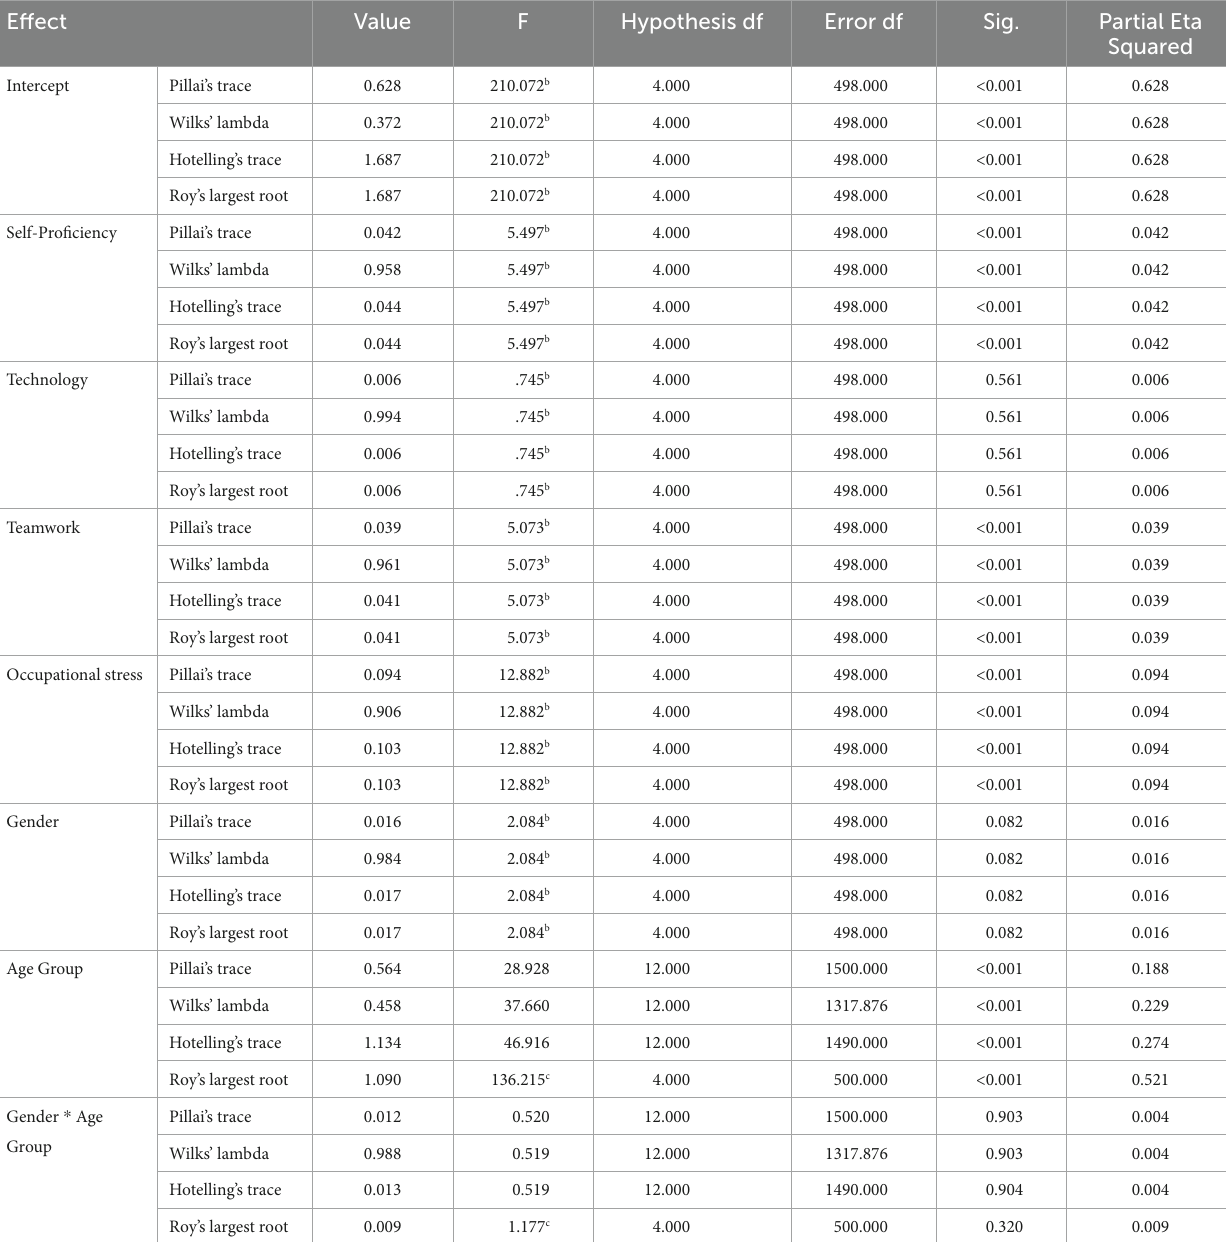
TABLE 8 General linear model: Multivariate tests a